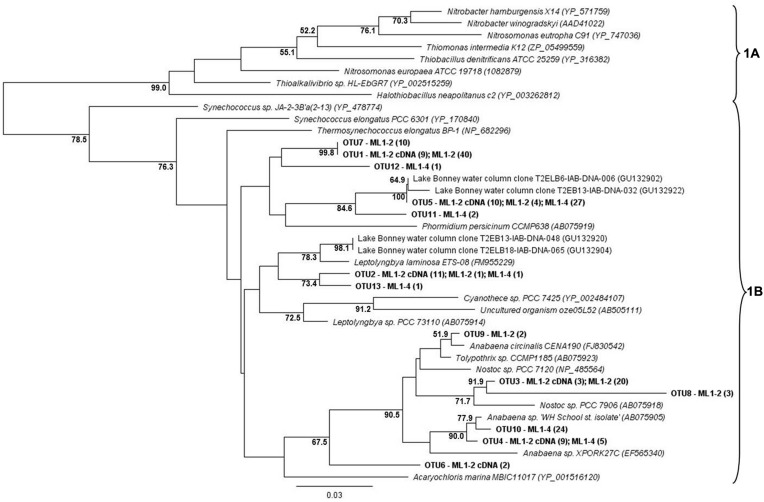
Neighbor joining tree showing the phylogenetic relationships of translated green-type cbbL sequences as based on 127 amino-acid residues. The tree was constructed using the Jukes-Cantor distance model. Sinorhizobium meliloti 1021 (NP_436731) was used as an out-group and has been removed from the tree. Bootstrap supports are indicated as percentages (>50%) of 1000 replicates.